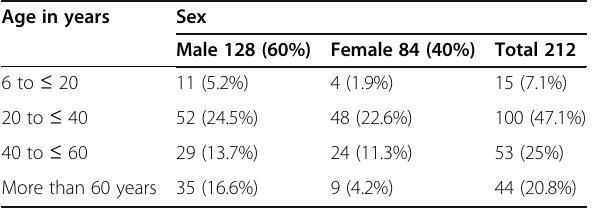
Table 1 Demographic data of the studied 212 patients Age in